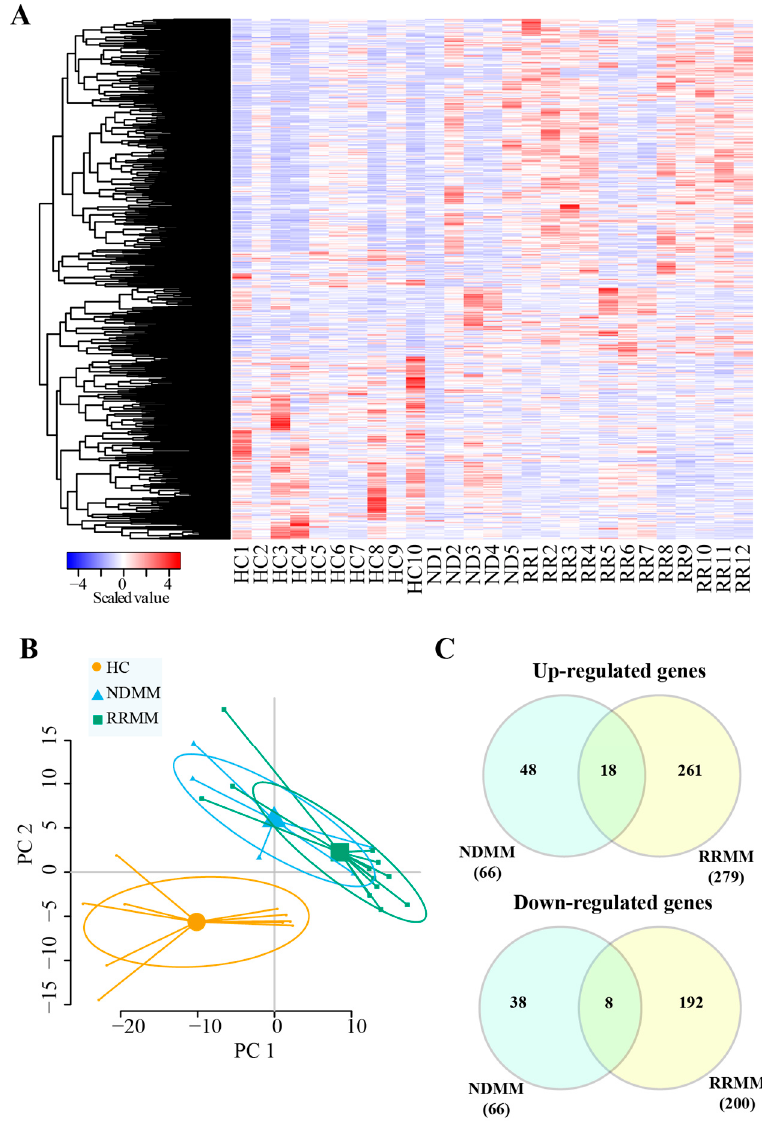
Figure 2. Comparison of DEGs in NDMM and RRMM. ( A ) A heat map of the DEGs showed different signatures for HC, NDMM, and RRMM. ( B ) Principle component analysis of all samples. ( C ) Venn diagrams of up- and down-regulated genes identified in all MM patients, NDMM, and RRMM.